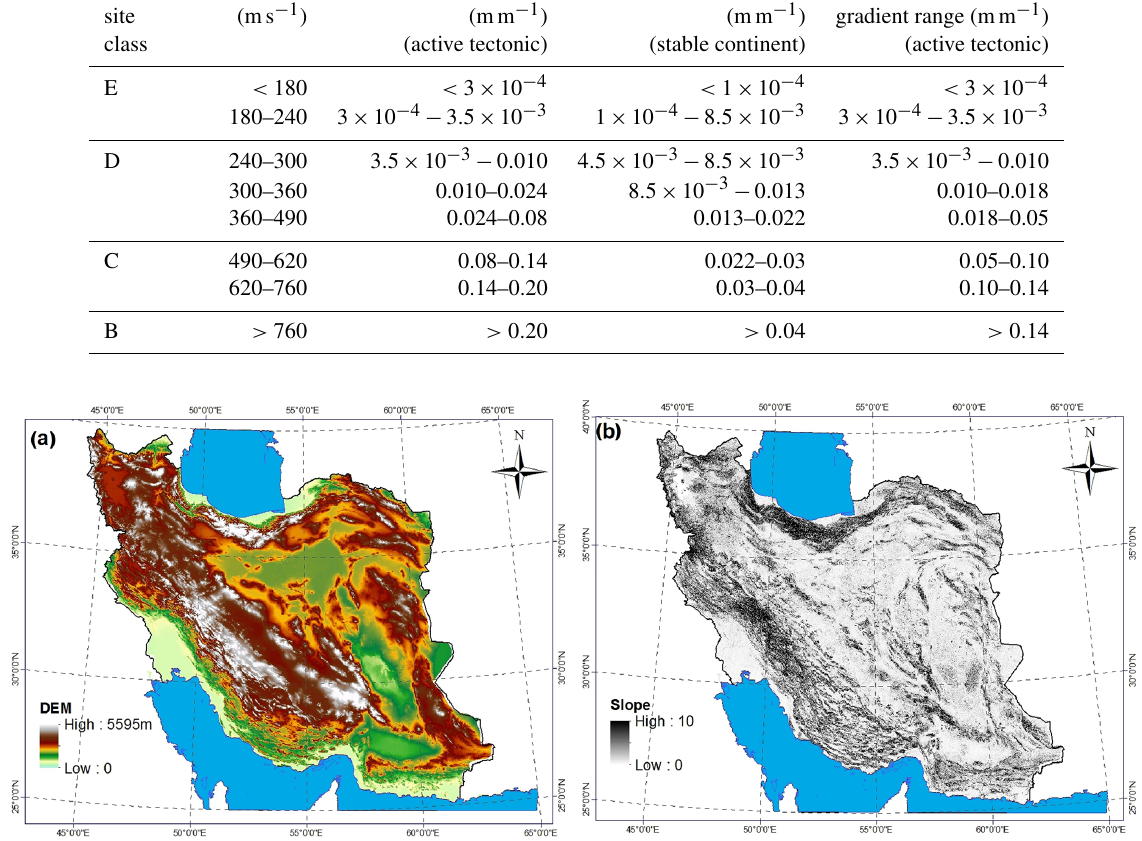
Figure 3. (a) Global 1arcsec (30m) SRTM digital elevation model (DEM) of Iran, (b) slope map of